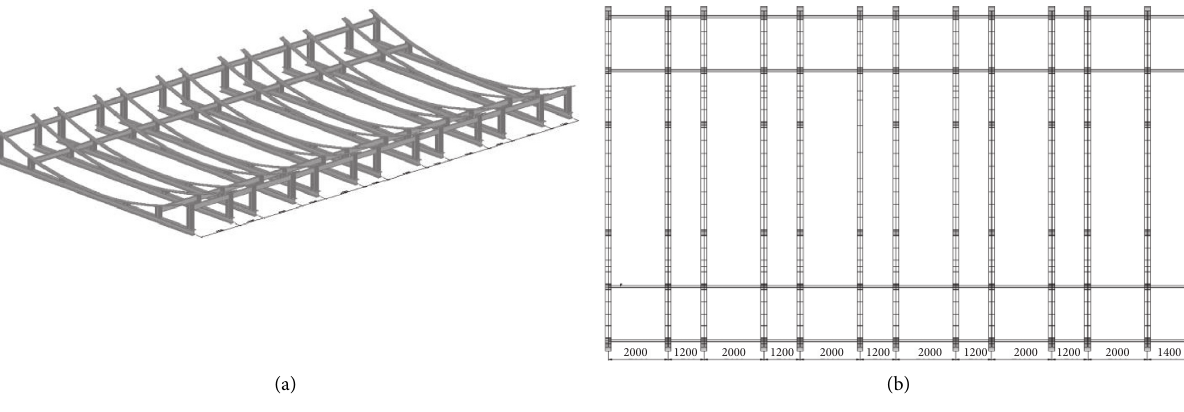
Figure 12: Lower assembly jig: (a) 3D model; (b) top